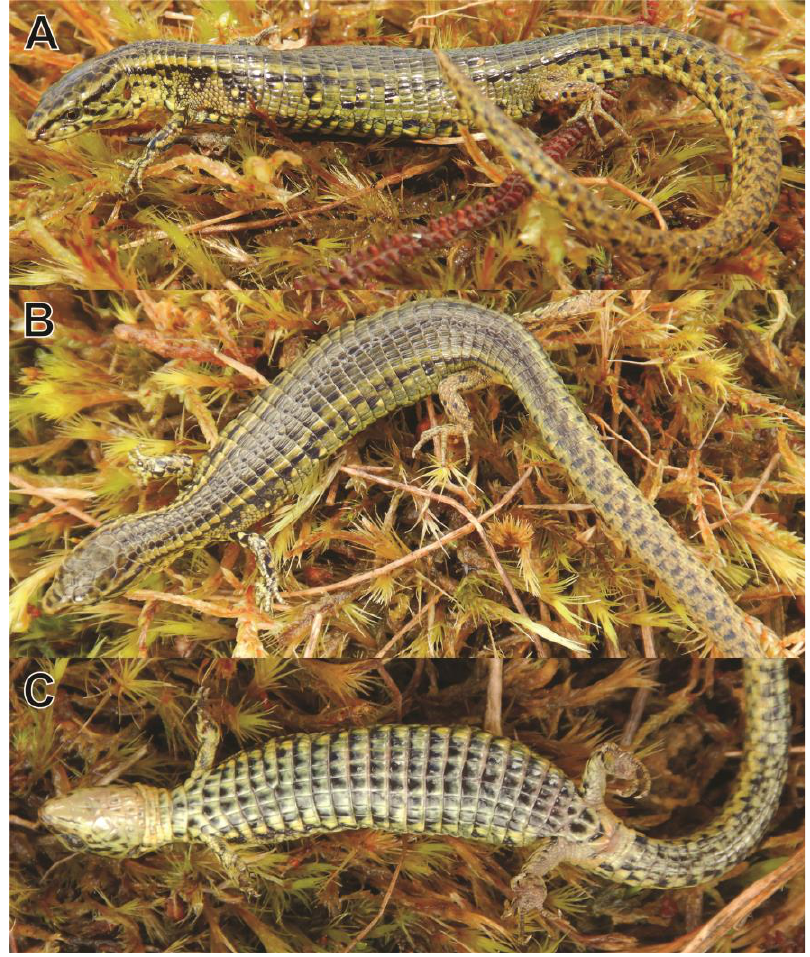
Figure 7. Life female of Proctoporus titans sp. nov. (MUSM 40915, paratype) in dorsolateral ( A ), dorsal ( B ), and ventral views ( C ). SVL 46.0 mm.